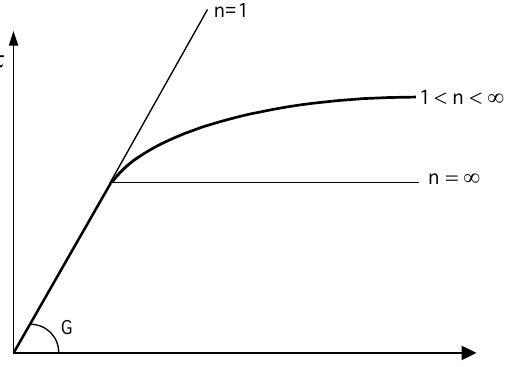
Figura 13: Curva tensioni deformazioni utilizzata per al formulazione matematica del